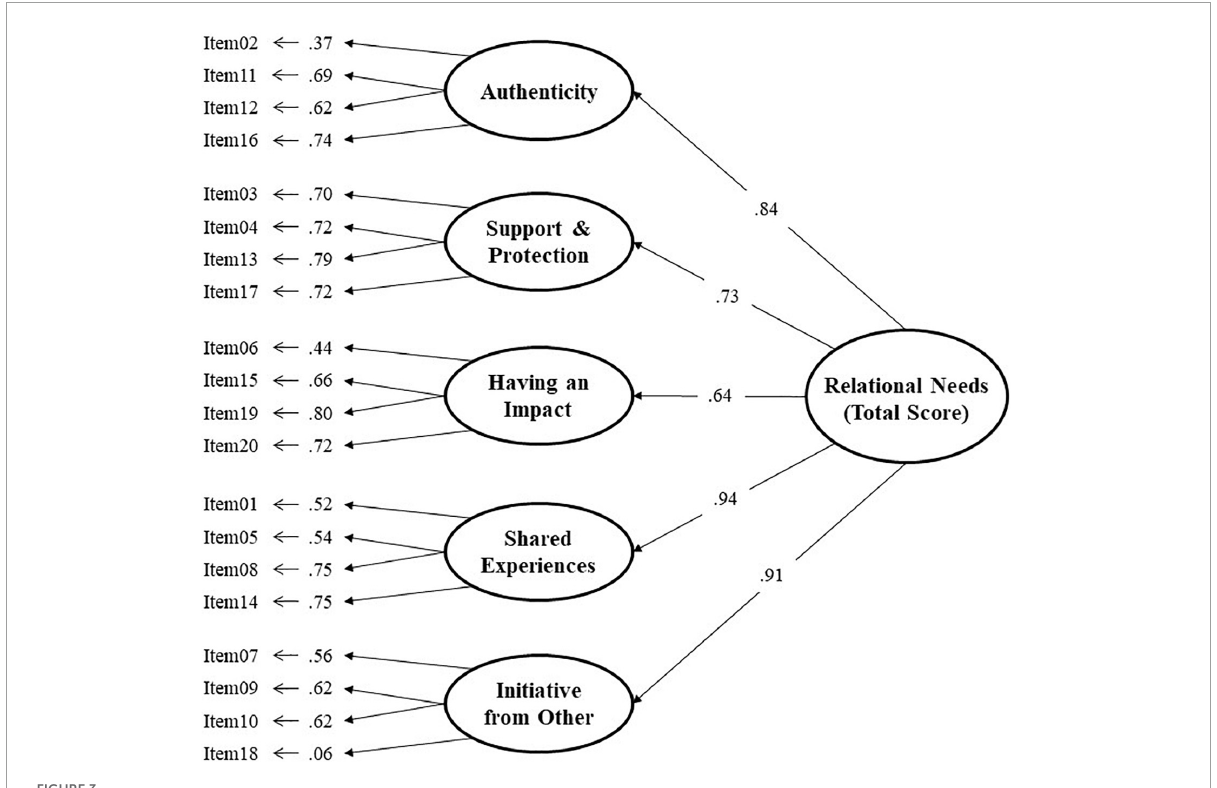
FIGURE3 Hierarchical model of